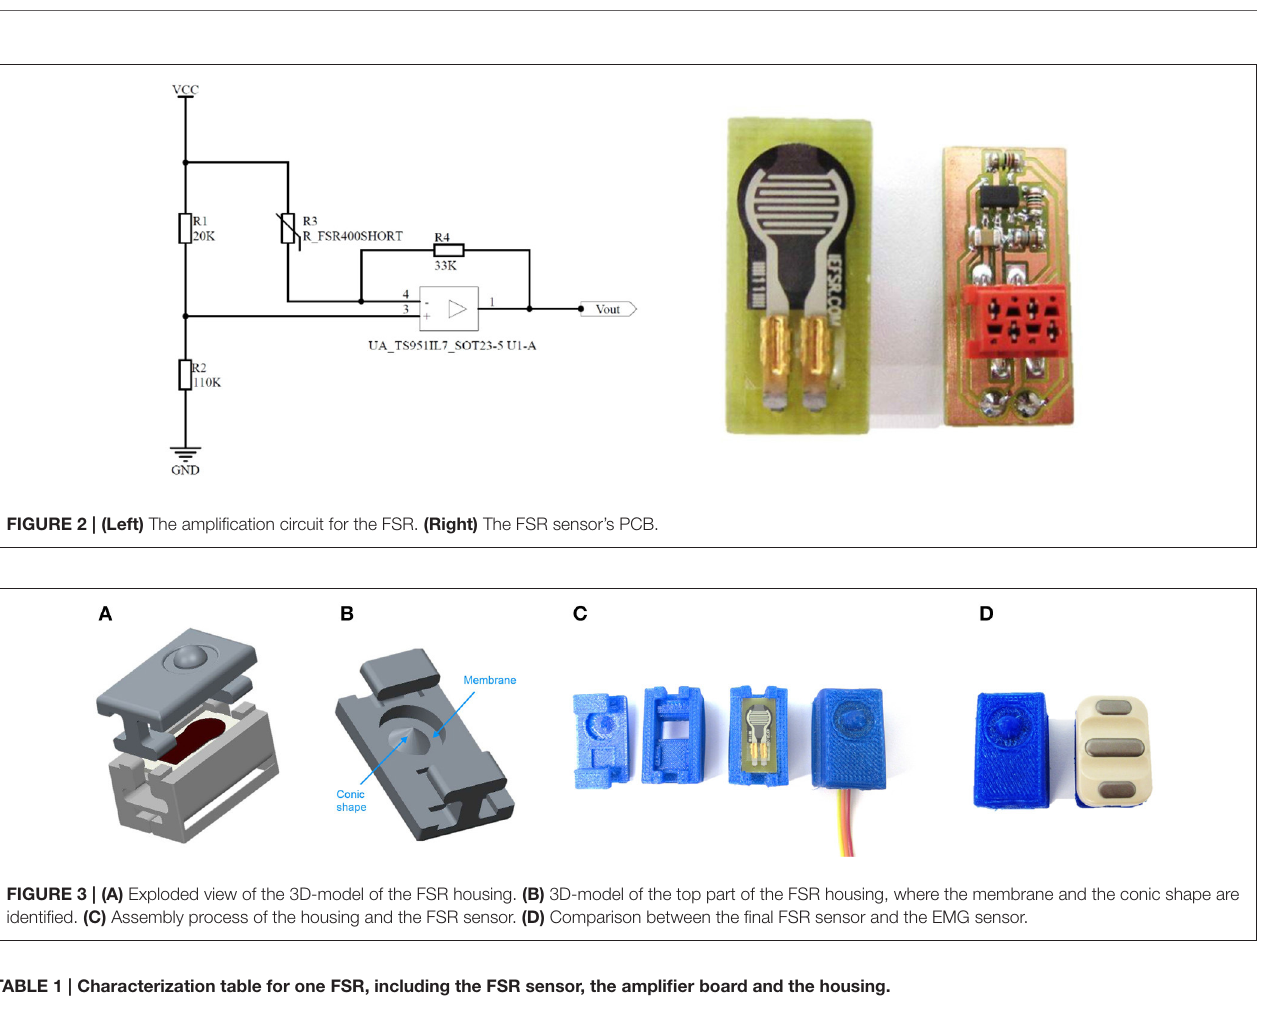
TABLE 1 | Characterization table for one FSR, including the FSR sensor, the amplifier board and the housing. Applied force [N]